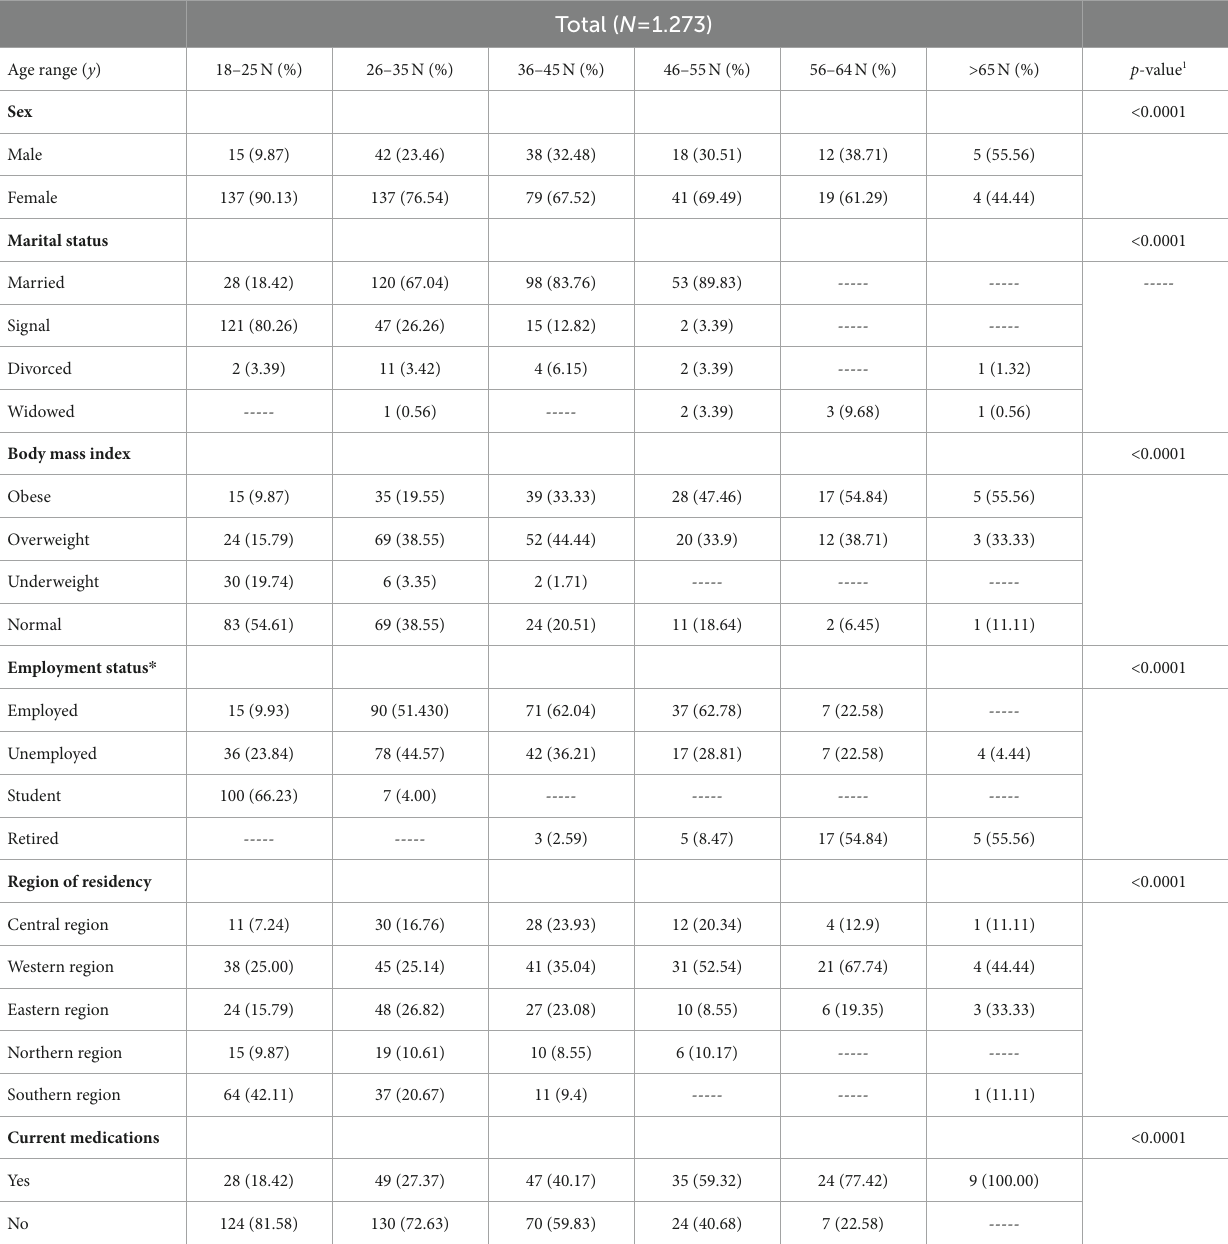
TABLE 2 Prevalence of dizziness across age groups (univariate analysis).